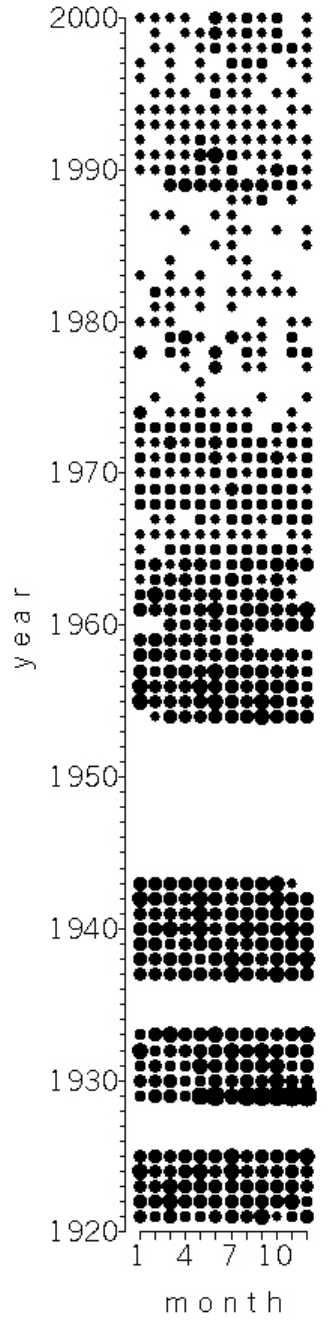
Fig. 2. Sampling strategy at RV001 in the 1921–2000 interval. Cir- cle diameter is proportional to the number of casts (with measure- ments of both temperature and salinity) per month